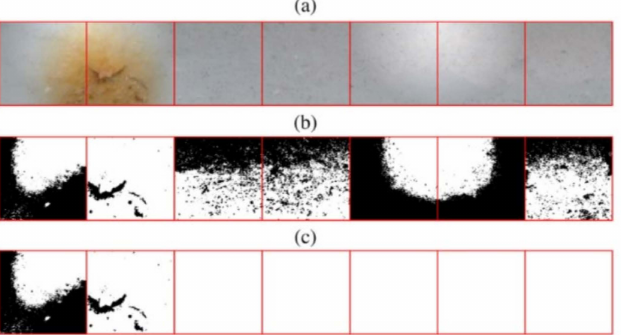
Figure 32. ( a ) Original image with added artificial light; ( b ) processed results using K-means, rust percentage of 43.67% with the processing time of 1.75 s; ( c ) processed results using RUDERM and K-means combined system, with 8.63% rust percentage and processing time of 1.18 s